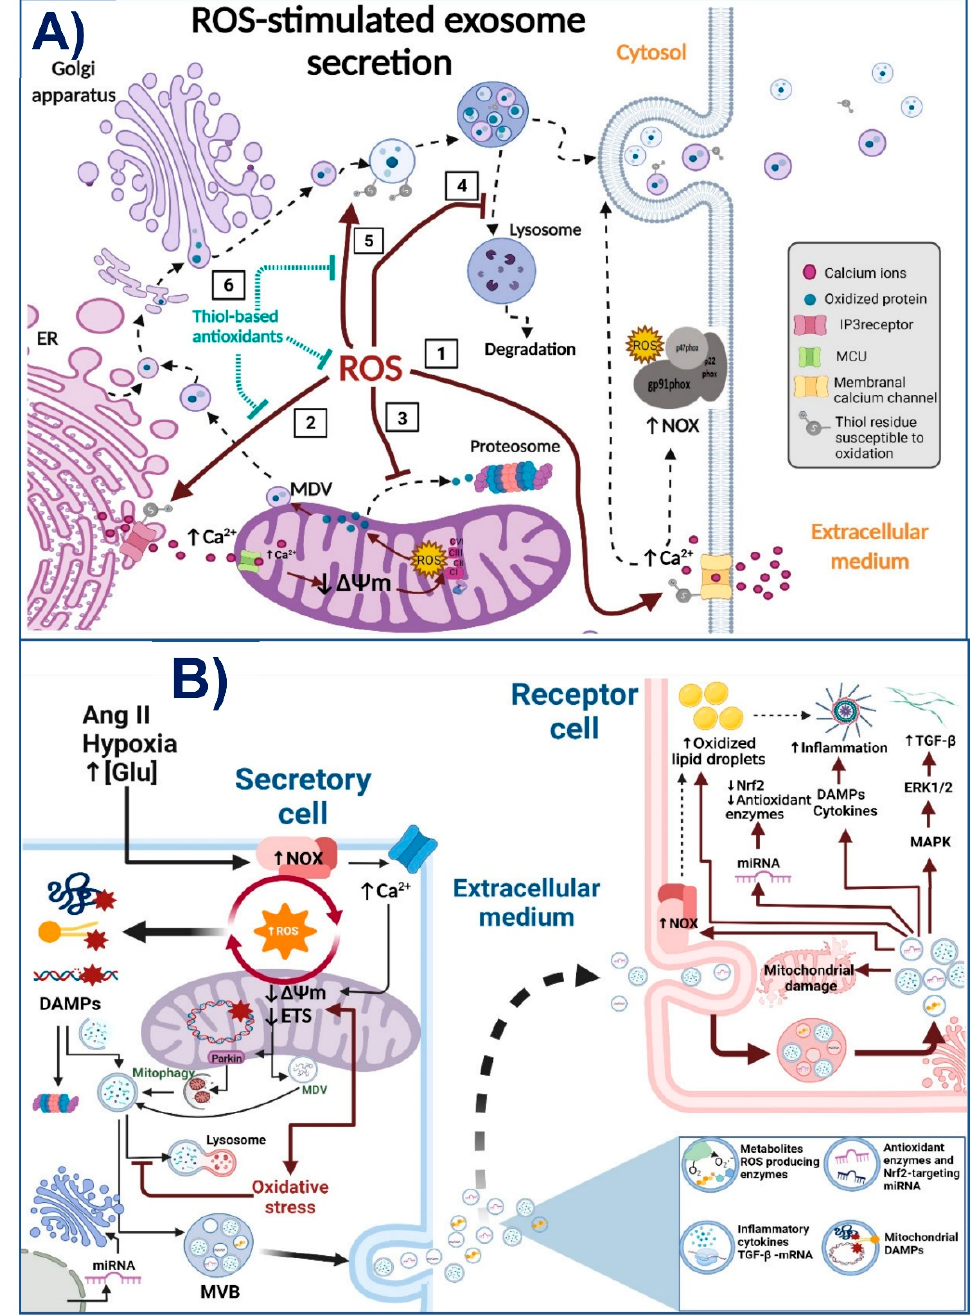
Figure 5. ( A ) Reactive oxygen species (ROS)-induced extracellular vesicles’ (EVs) secretion. ROS induce the EVs’ secretion by ( 1 ) post-translational modification of cysteine residues (Cys) in the membrane Ca 2+ channel, regulating the activity of this channel and increasing Ca 2+ cytosolic concentration. This Ca 2+ increase can also favor NADPH oxidase (NOX) activation, increasing ROS production even more. Additionally, ( 2 ) ROS also modulate the inositol trisphosphate receptor (IP3) by Cys modification, increasing the endoplasmic reticulum Ca 2+ release, which also favors EVs’ release and mitochondrial ROS production by mitochondrial membrane potential ( ΔΨ m) depolarization and electron transport system (ETS) inhibition. ( 3 ) ROS inhibit the degradation of damaged mitochondrial components by the proteasome, which enhances the incorporation of these damaged components in mitochondrial-derived vesicles (MDVs). MDVs are normally incorporated in multivesicular bodies (MVBs) to be degraded by autophagy. However, ( 4 ) under oxidative stress, the inhibition of autophagy flux by ROS prevents the incorporation of the autophagosome into the lysosome, increasing the excretion of mitochondrial damaged components into exosomes.